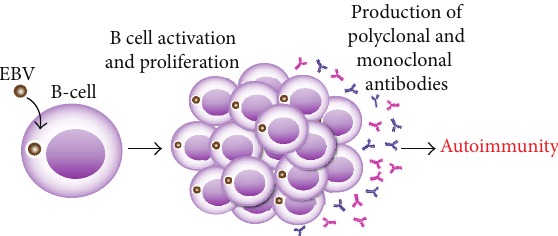
Figure9:Infections,Bcells,andautoimmunity.Prolongedinfectionwithavirus,suchasEBV,canleadtoconstantactivationandproliferation of B cells, resulting in the production of monoclonal and polyclonal antibodies as well as immune complexes, causing autoimmune